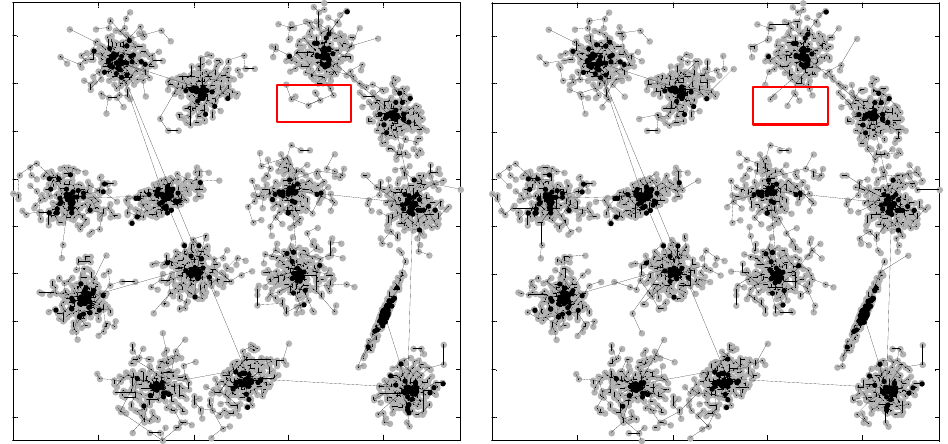
Figure A1. The experiment for showing the negligible influence of data index. Take dataset “S1” for instance. In order to show the effect of data index, we first generated lots of vertices with identical potentials, since only for these vertices, their data index may serve as a reference for identifying parent nodes. We set σ as 10, much less than the average pair-wise distance. Consequently, only 151 potential values are unique, which means that most vertices have the same potentials. We randomly changed the data index for 50 times, and the In-Trees of two of the 50 runs are shown in this figure. It is clear that for the edge points in the red rectangles, local difference occurs in their neighborhood relationships, whereas this difference makes very little effect on the final clustering results. In fact, (i) for the in-trees of all 50 tests, we found that the longest 100 edges are the same; (ii) for the clustering results of all 50 tests, when we took one (e.g., the first clustering result) as the benchmark and compared it with the other 49 clustering results, relative clustering error rate were very small, 0.0074 ± 0.0041 (mean ± standard deviation), which means that on average, 37 points out of 5000 get different assignments. To summarize, although the nearest descent rule involves data index item, the change of the data indexes makes negligible influence on the final clustering